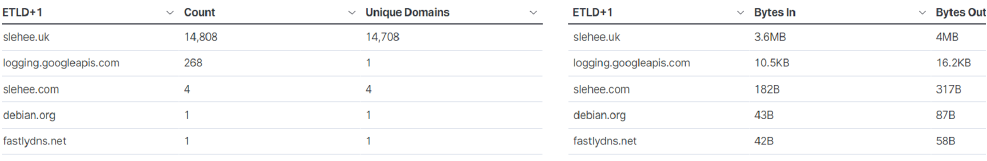
Figure 15. Unique subdomains per domain shown in the Kibana visualisation